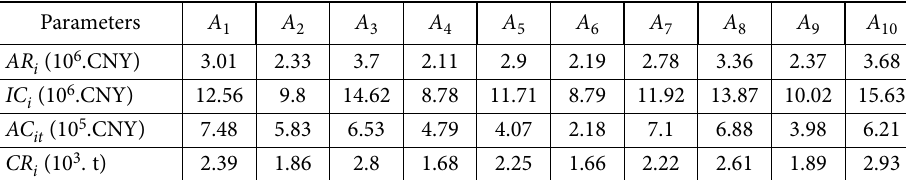
Table 8. Values of parameters to build Model 3 (source: Wu et al., 2018)